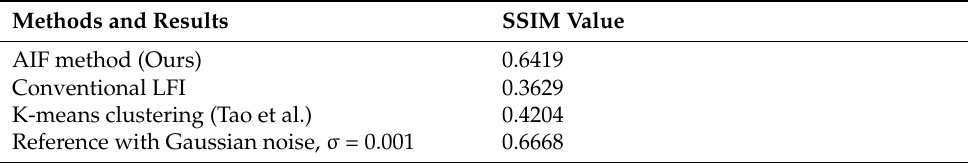
Table 1. SSIM results of the “idealized” sample with different reconstruction methods. Methods and